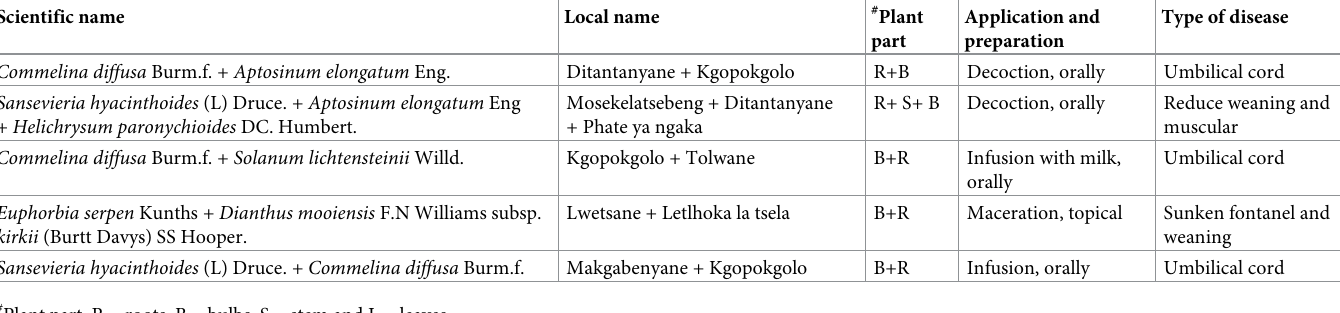
Table 5. Plant combinations used for treating childhood diseases in Ngaka Modiri Molema and Bojanala districts of North West Province, South Africa. Scientific